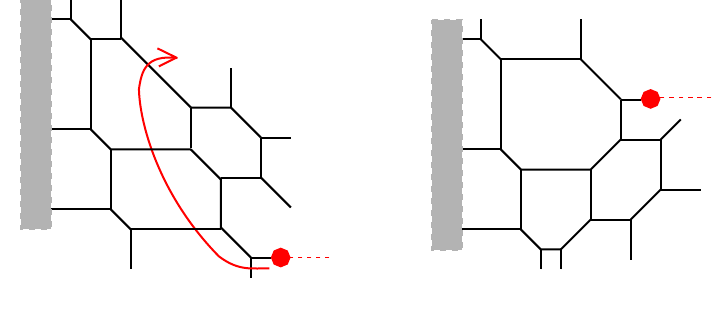
Figure 18 . Distribution duality in the S-dual